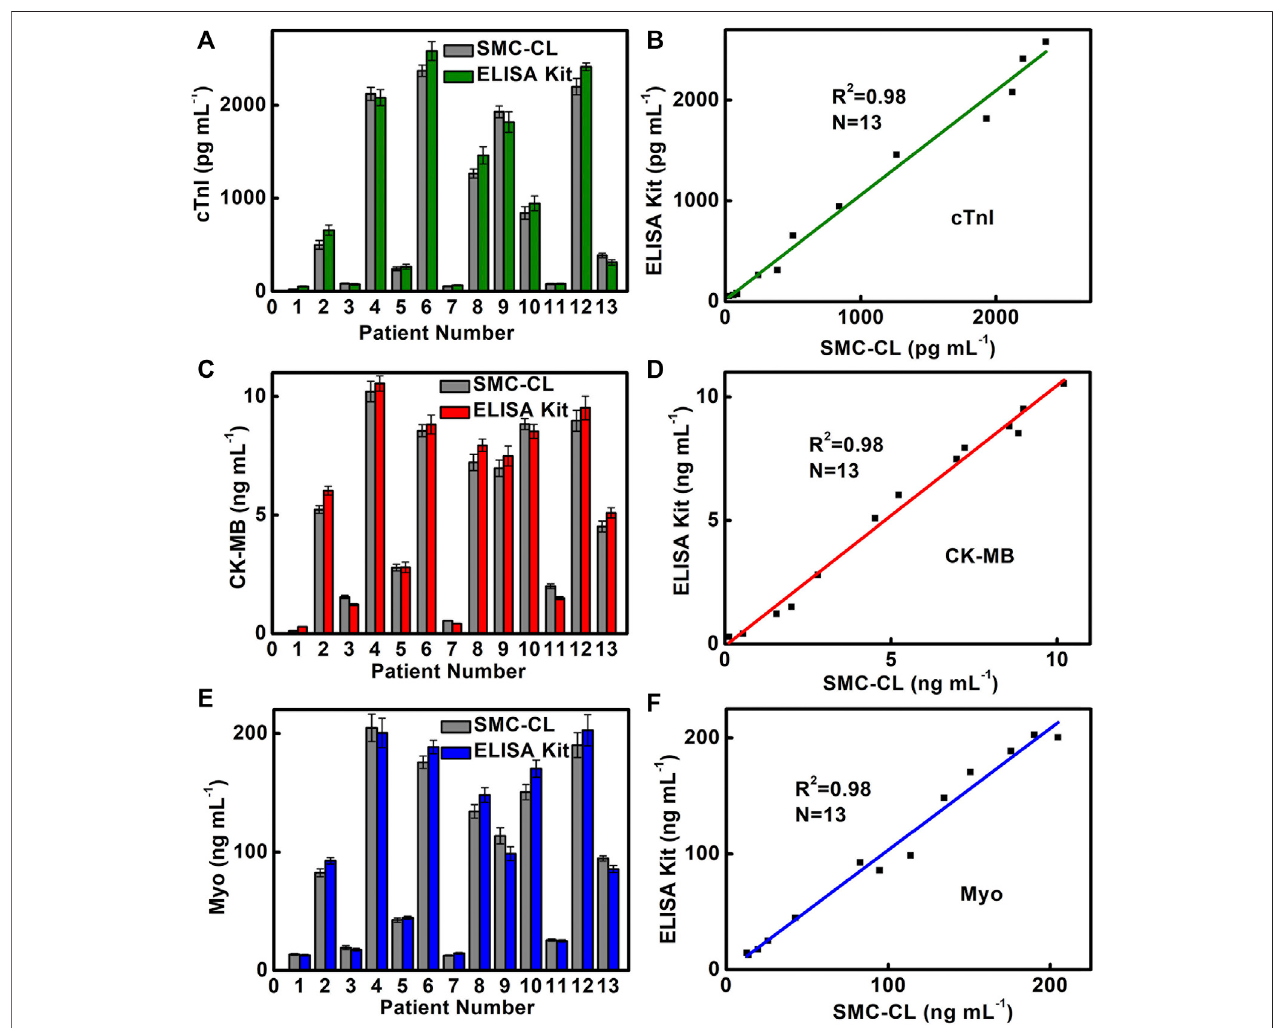
FIGURE 6 | Comparison of (A) cTnI, (C) CK-MB, and (E) Myo detection results and correlation analysis of (B) cTnI, (D) CK-MB, and (F) Myo in clinical samples by SMCandthecommercialELISAKit.SampleNos.1,3,7,and11arefromhealthypeopleforthecontrolexperiment.SampleNos.2,4,5,6,8,9,10,12,and13arefrom AMI patients.